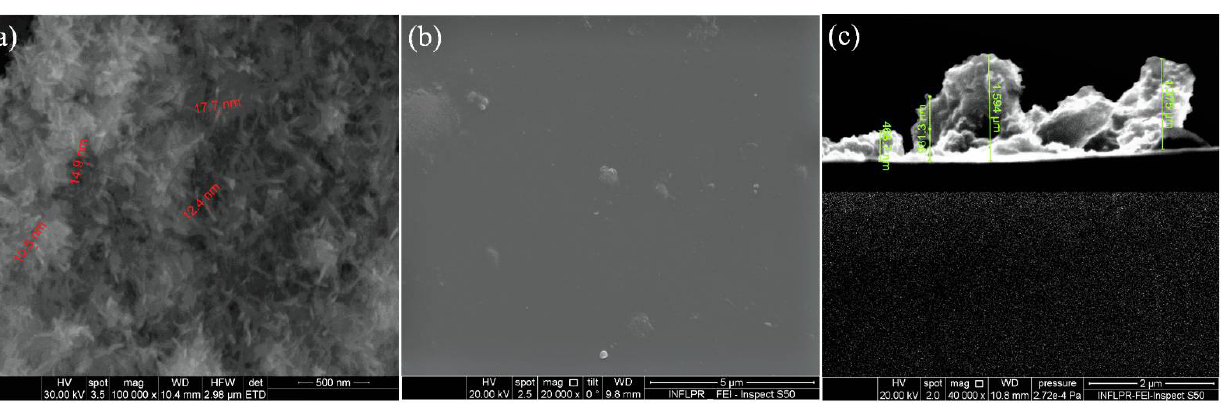
Figure 4. SEM images of HAp/CS/FGF2 ( a , b ) coatings obtained at 300 mJ/cm 2 laser fluence and ( c ) cross section.